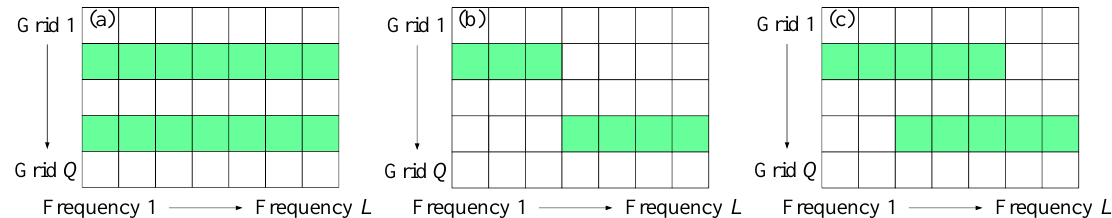
Figure 1. The signals with ( a ) the same, ( b ) non-overlapped and ( c ) partially overlapped frequency bands. The white and green squares correspond to the absence and presence of a signal, respec- tively.